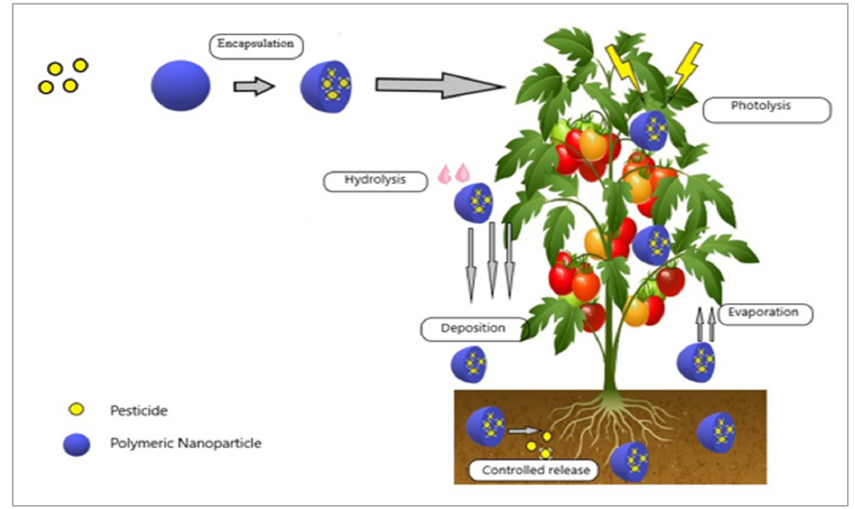
Figure 2. Encapsulation of pesticides into NPs for site-directed delivery and to avoid premature